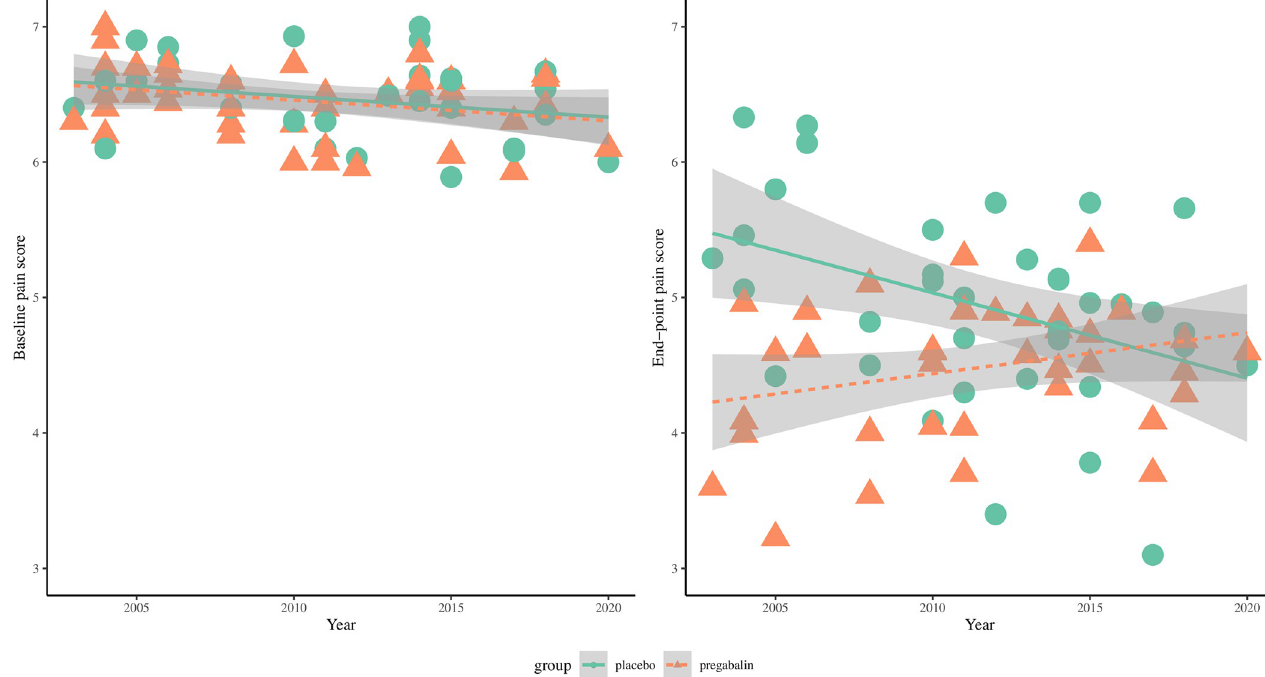
Fig 7. Baseline and end-point pain scores in the pregabalin and placebo groups, 2003–2020. Pearson’s correlation (r) for change in within-group pain scores over publication year at baseline: placebo, r = -0.20; pregabalin, r = -0.15; at end-point: placebo, r = -0.38; pregabalin, r = 0.22.